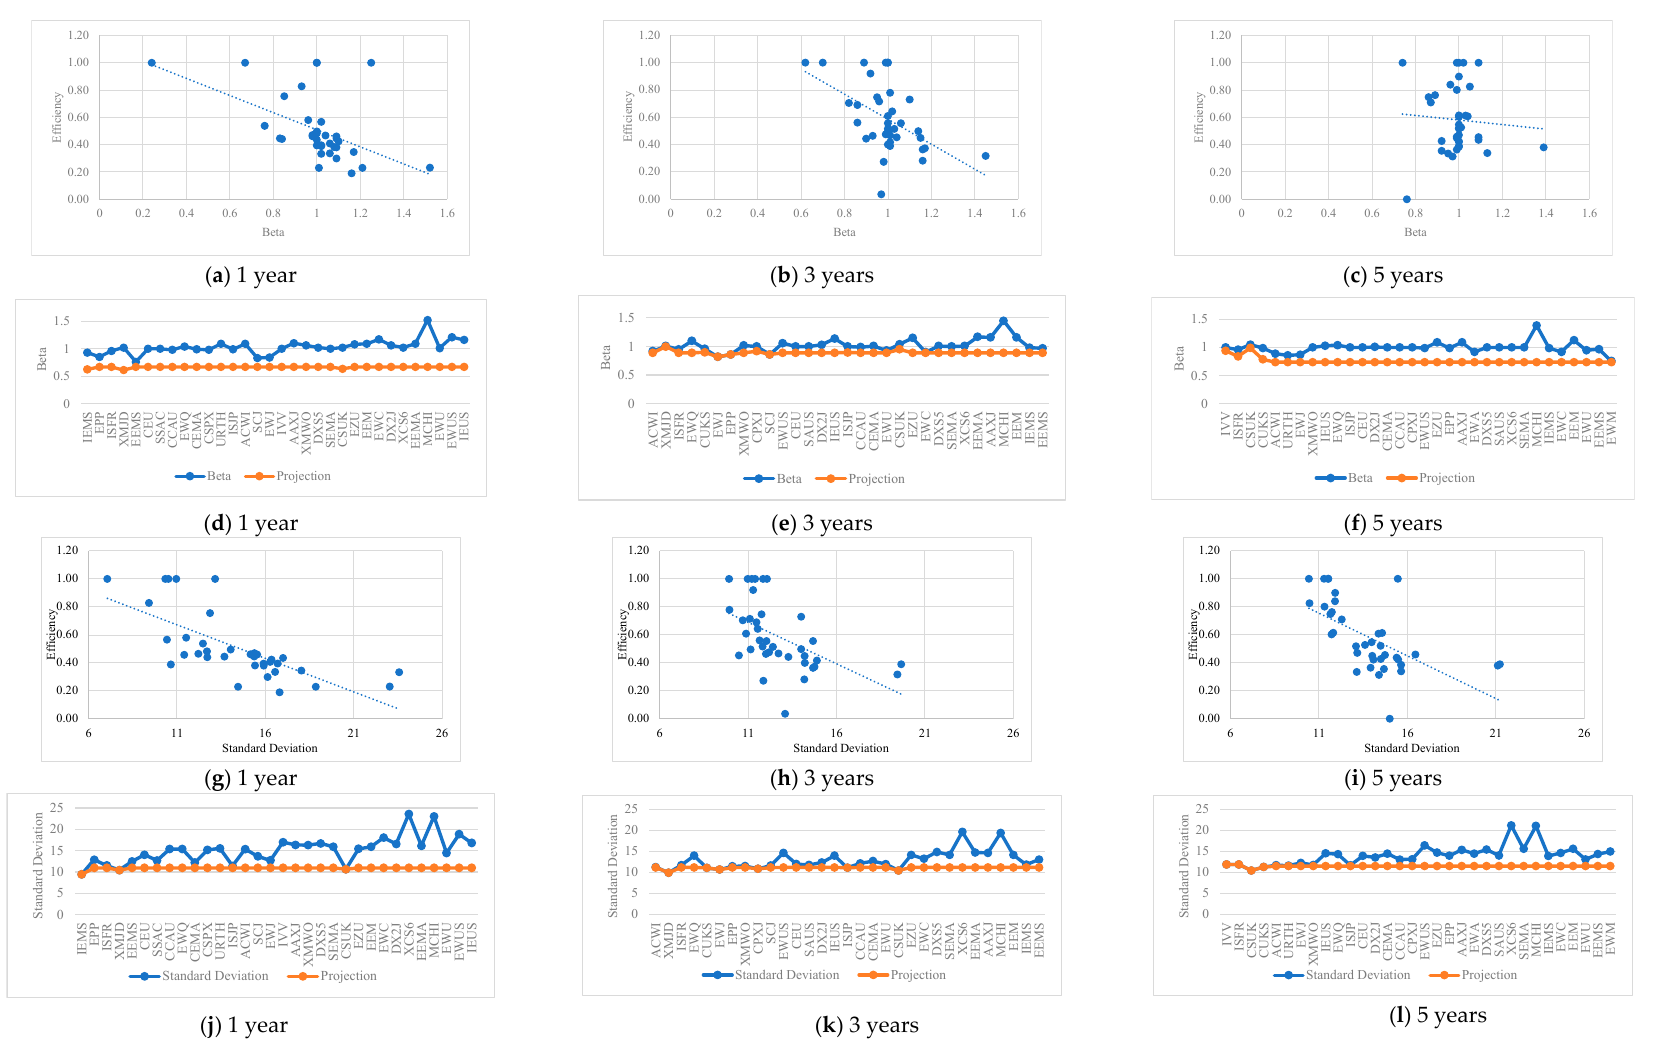
Figure 2. Efficiency scores vs. outputs and projections (ETFs are ordered in decreasing order of efficiency) for the different time horizons–M1.